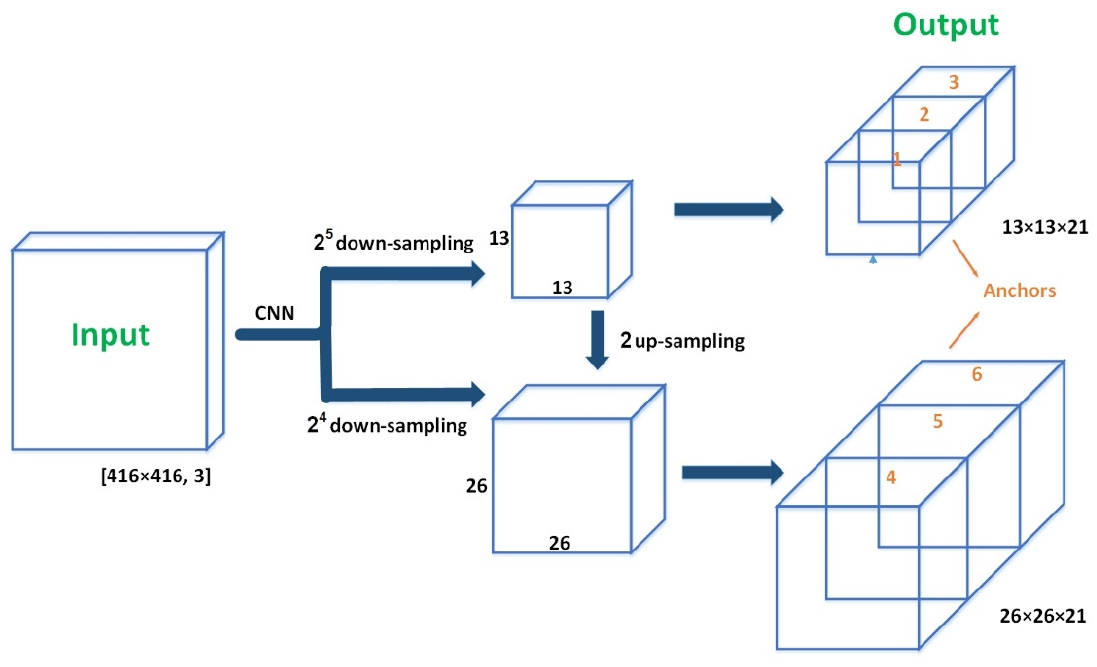
Figure 1. The network structure of CG-YOLO.